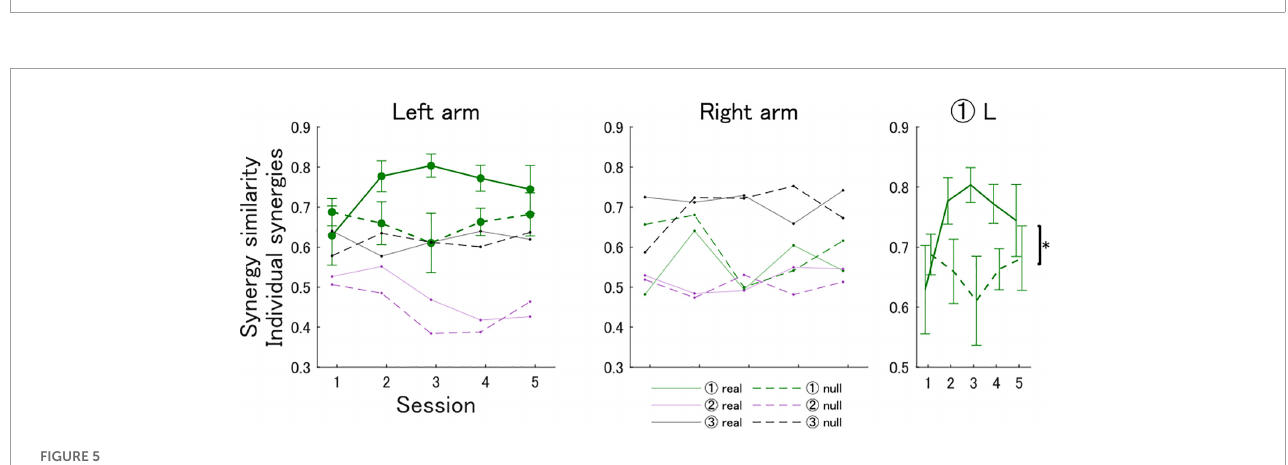
FIGURE4 Bimanual synergy similarity and importance metrics in the real and null feedback groups. (A) Mean synergy similarity metric. Thick lines indicate the mean score across participants in each group. Light lines indicate scores for each participant. Error bars indicate the standard error. (B) Cosine similarity metric of individual synergies (1–8). (C) Synergy importance of individual expert synergies (IMP s1 –IMP s8 ). The third column summarizes statistical comparisons. The S.I. legend indicates a significant interaction between session number and feedback type on the outcome variable.